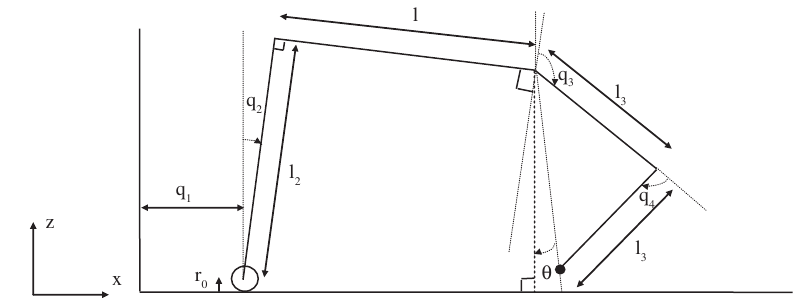
Figure 1: Legged robot actuated pneumatically Système à Pattes (SAP).